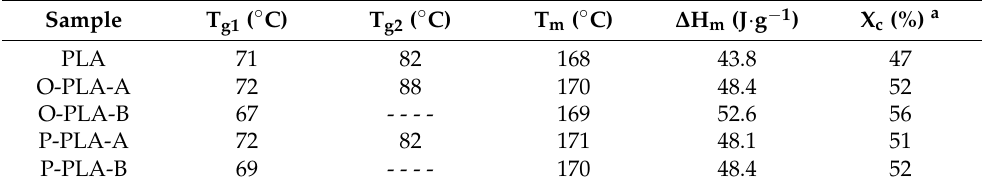
Table 6. DSC characteristic parameters of neat and functionalized PLA flat tapes by reactive